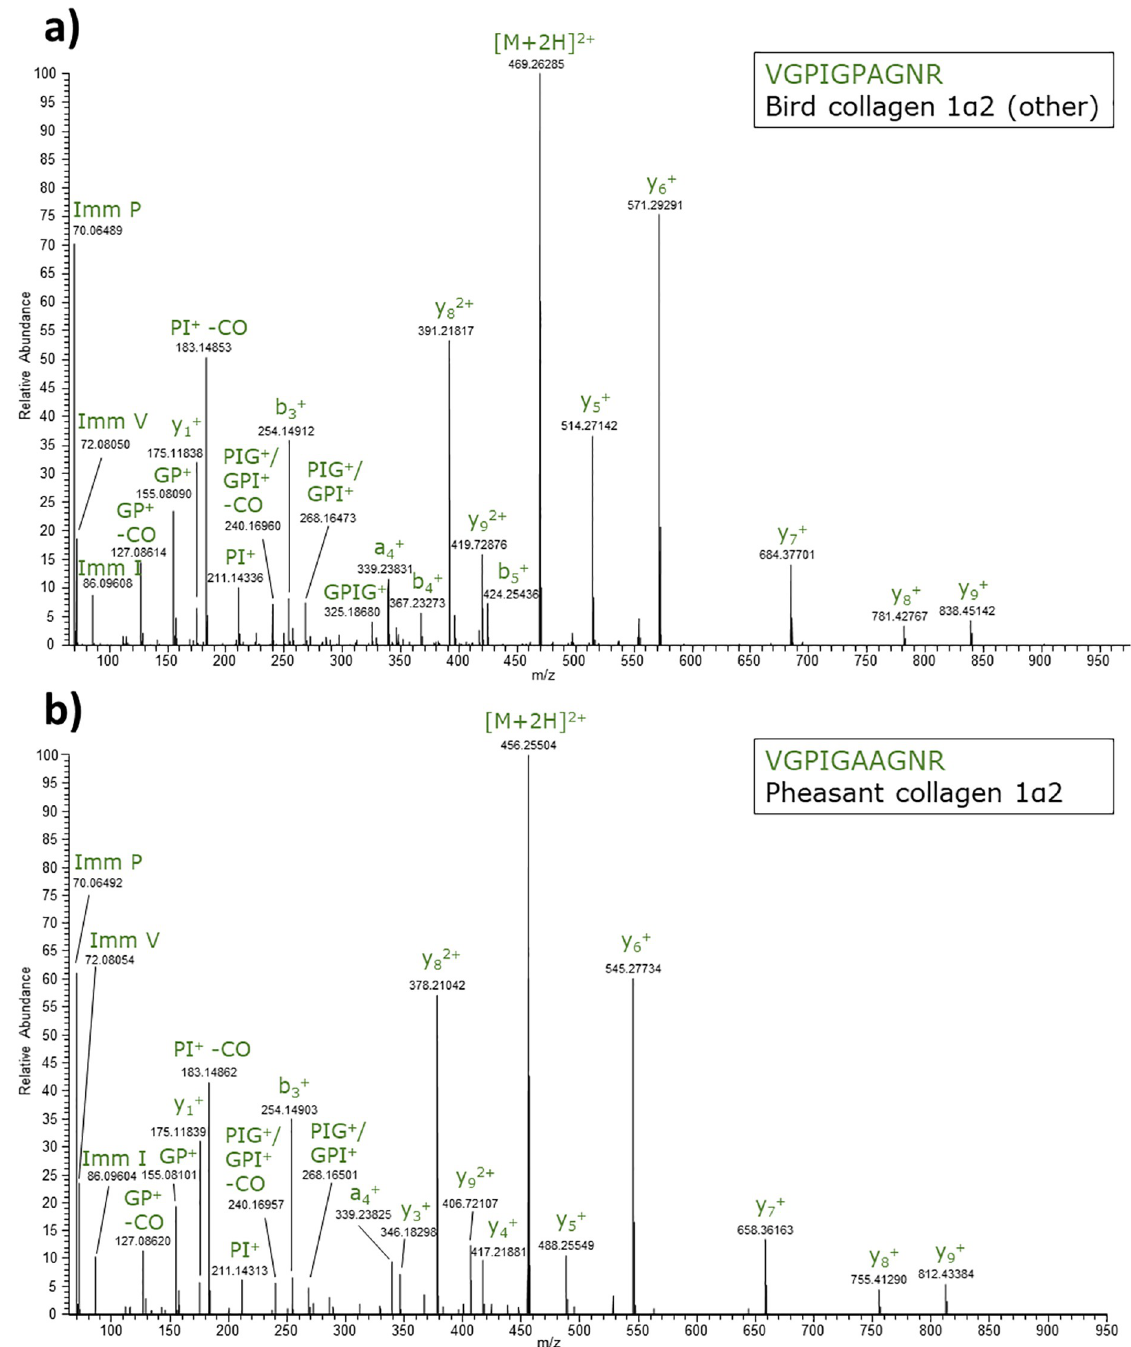
Fig 4. MS/MS spectra of VGPIGPAGNR/VGPIGAAGNR. MS/MS spectra of tryptic collagen 1 α 2 peptides from a) chicken (precursor m/z 469.26) and b) pheasant extract (precursor m/z 456.26). The chicken peptide VGPIGPAGNR is nearly generic for birds.